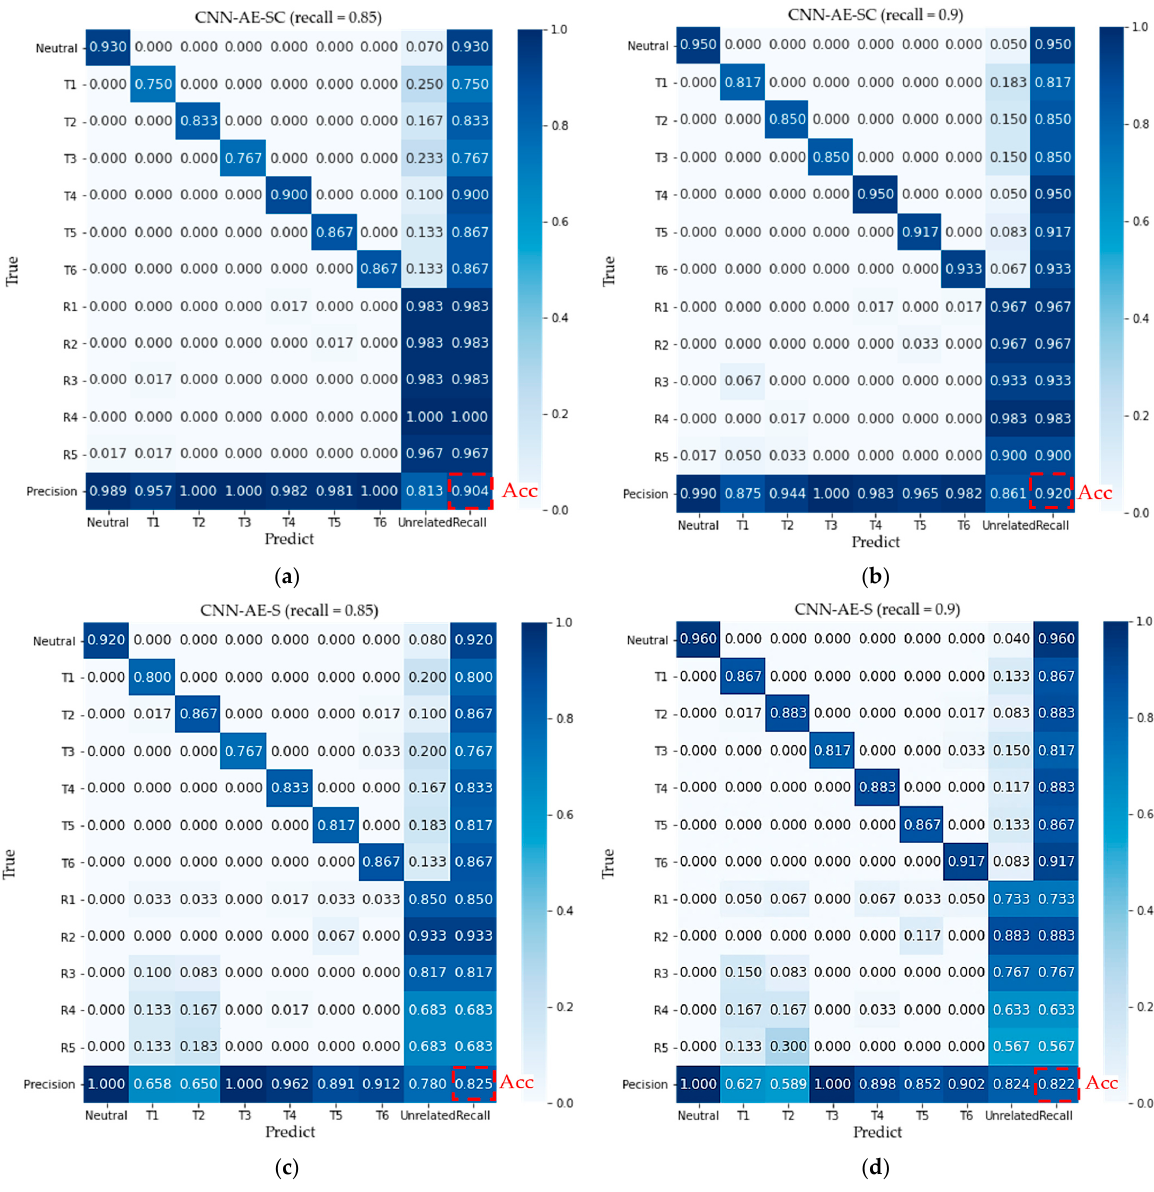
Figure 10. Confusion matrices averaged over all subjects: ( a , b ) Confusion matrices for the proposed method on the test dataset and all unrelated samples when the recall is defined as 0.85 and 0.9 ( b ); ( c , d ) Confusion matrices for CNN-AE-S method on the test dataset and all unrelated samples when the recall is defined as 0.85 and 0.9; Neutral and T1–T6 denote seven target movements, whereas R1–R5 denote rejection movements.